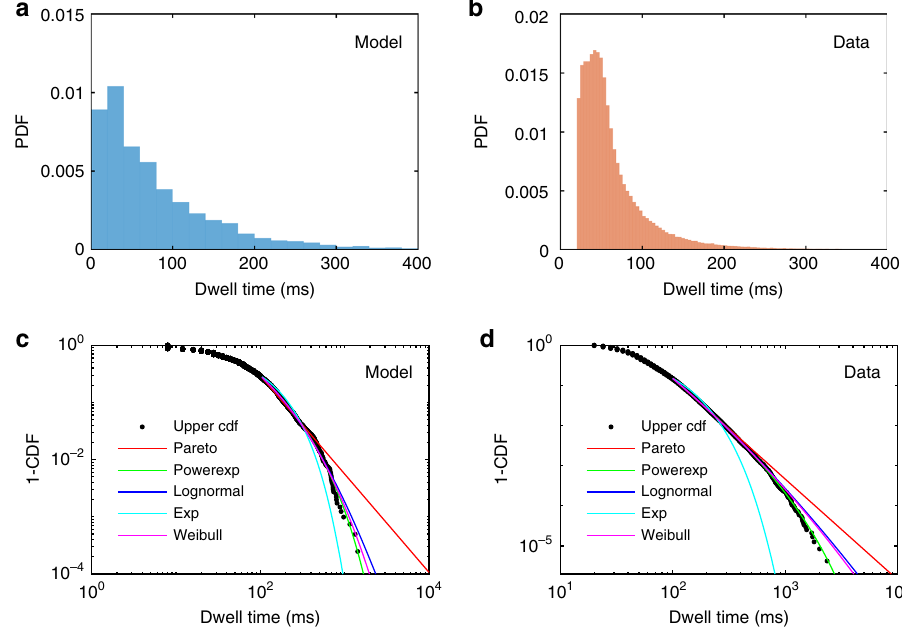
Fig. 4 Dwell-time distributions. a Model for c = 0.6, d = 1 ms. b Resting-state MEG data from ref. 52 . c , d Upper cumulative distributions (black circles) on double logarithmic axes for dwell times in c the model and d MEG data. Lines are maximum likelihood fi ts to upper tails for the power law (Pareto, red), exponentially truncated power law (green), lognormal (blue), exponential (cyan), and stretched exponential (Weibull, magenta) distributions. Tail cutoffs at dwell times of 100 ms. Source data are provided as a Source Data fi